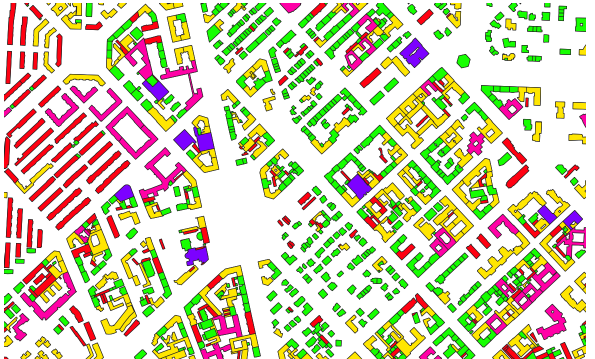
Figure 5. K-Means clustering on buildings data and manually selected features with 6